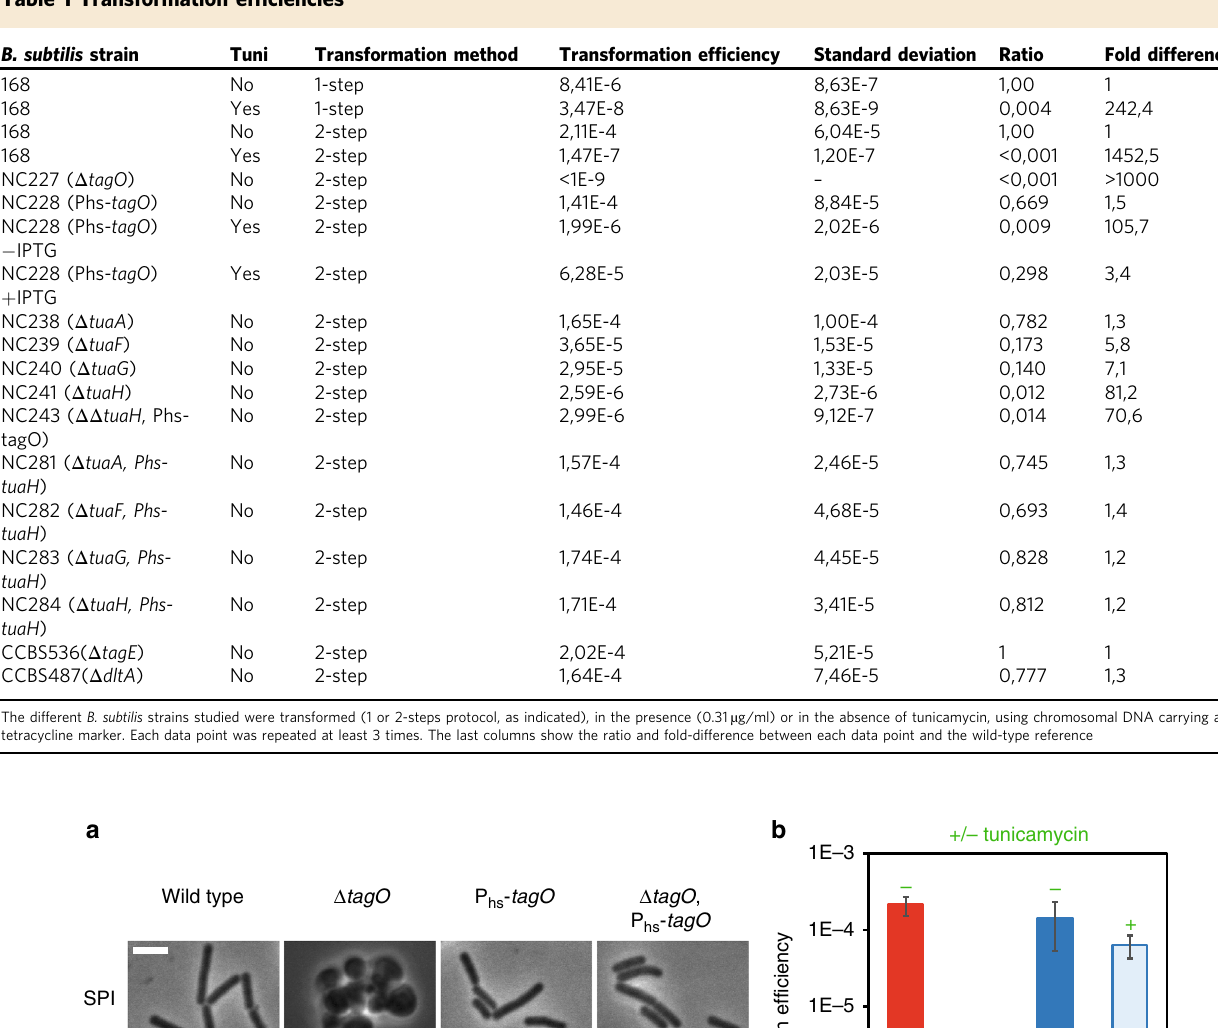
Table 1 Transformation ef fi ciencies